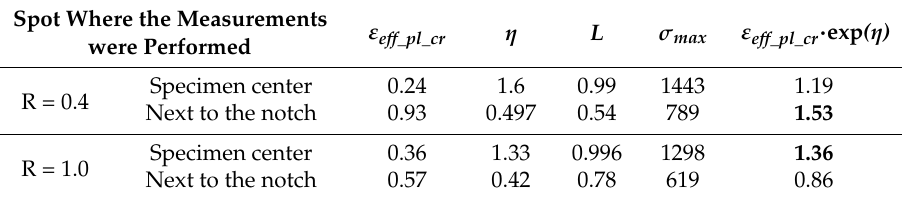
Figure 6. Distribution of η , L , ε eff_pl functions. ( a ) Specimen C04, material HW, temperature +20 °C, last step of the integration. ( b ) Specimen C1, material HW, temperature +20 °C, last step of the integration. Table 2. Values of the mechanical field parameters at the critical moment along the fracture surface for C04 and C1 specimens, material HW, temperature +20 °C.